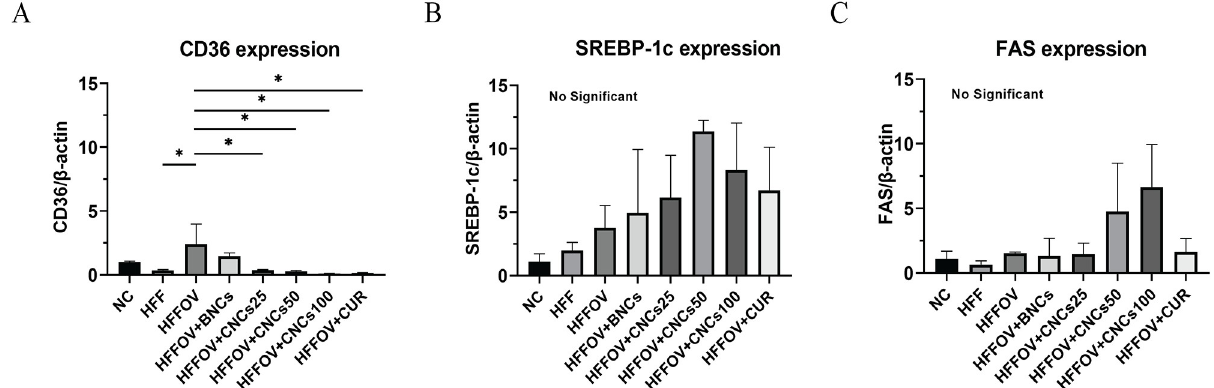
Fig 7. Effects of curcumin-loading nanocomplexes on mRNA expressions levels. A): CD36 associated with free fatty-acid uptake by liver cells; B): SREBP-1c; and C): FAS associated with lipid synthesis. Expression levels were measured at the end of the 3-month experimental period. For each group, total RNA was measured from the tissues of three hamsters and the mean ± SD shown. Statistical analyses were done using one-way ANOVA � P < 0.05 (Tukey’s multiple comparisons test). Abbreviations are the same as in Fig 3 legend.